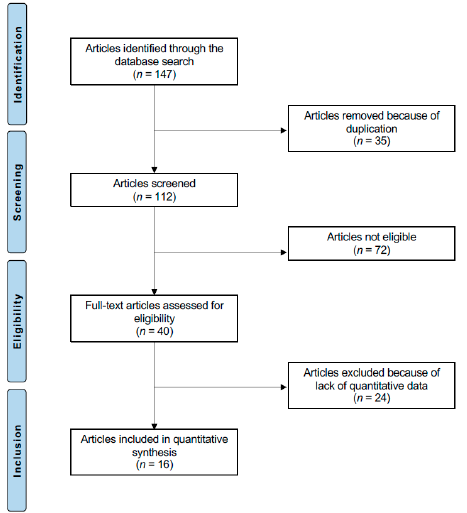
Figure 1. Literature search flow